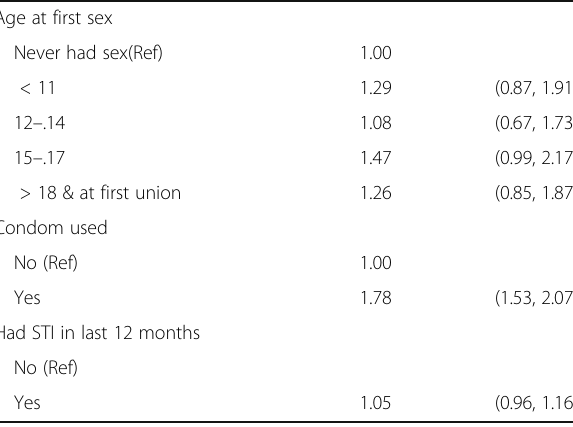
Table 4 Estimated covariate effects and their 95% credible